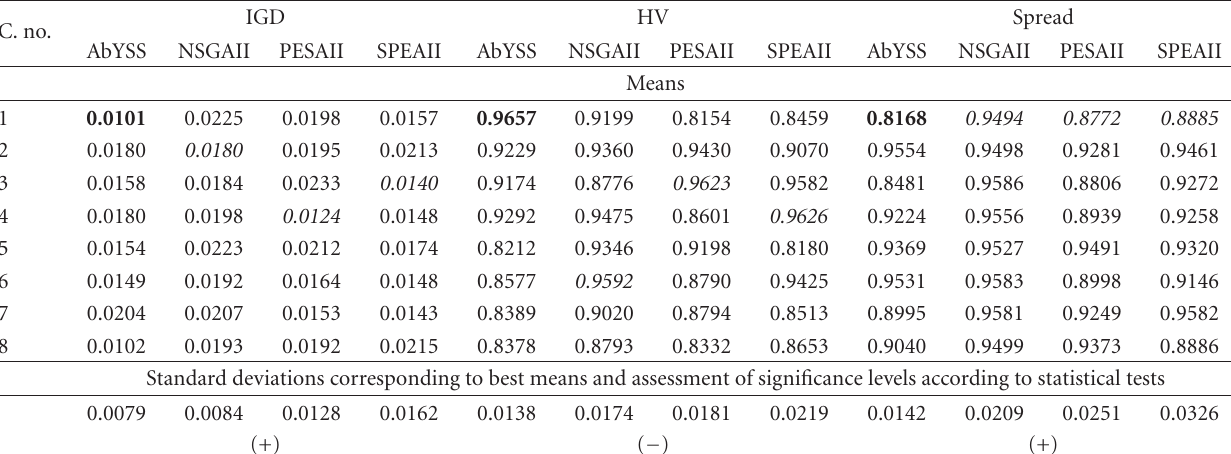
Table 7: Values of measurement quantities obtained by “Eval. Number = 5,000” and “Pop. Size = 100” for design example 3. C.